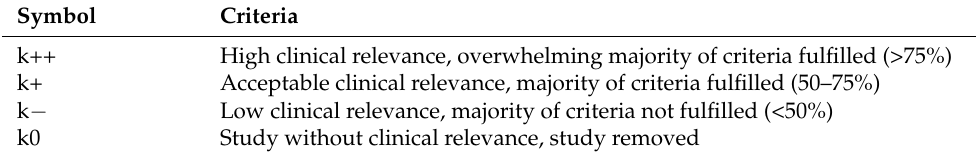
Table 3. Rating of clinical